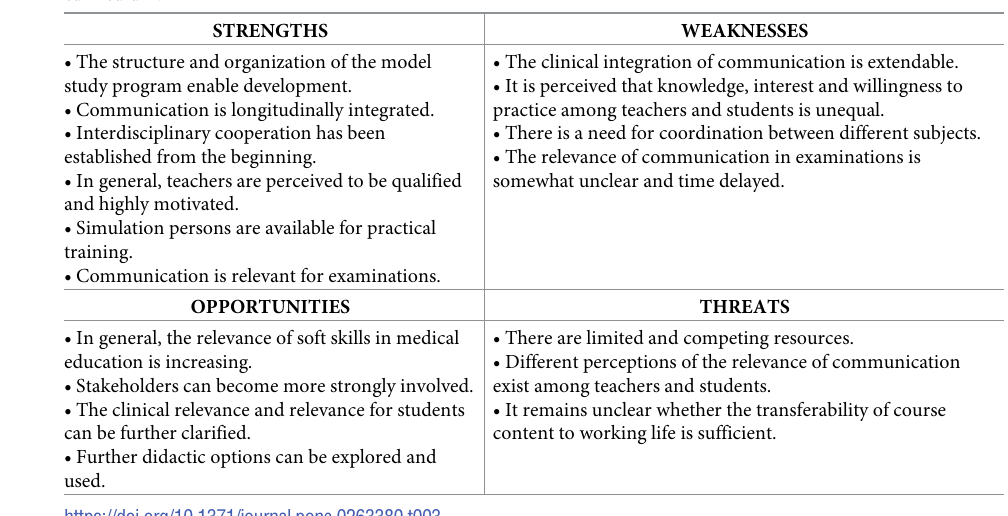
Table 3. Overview of the main findings of the SWOT analysis regarding the integration of communication in the